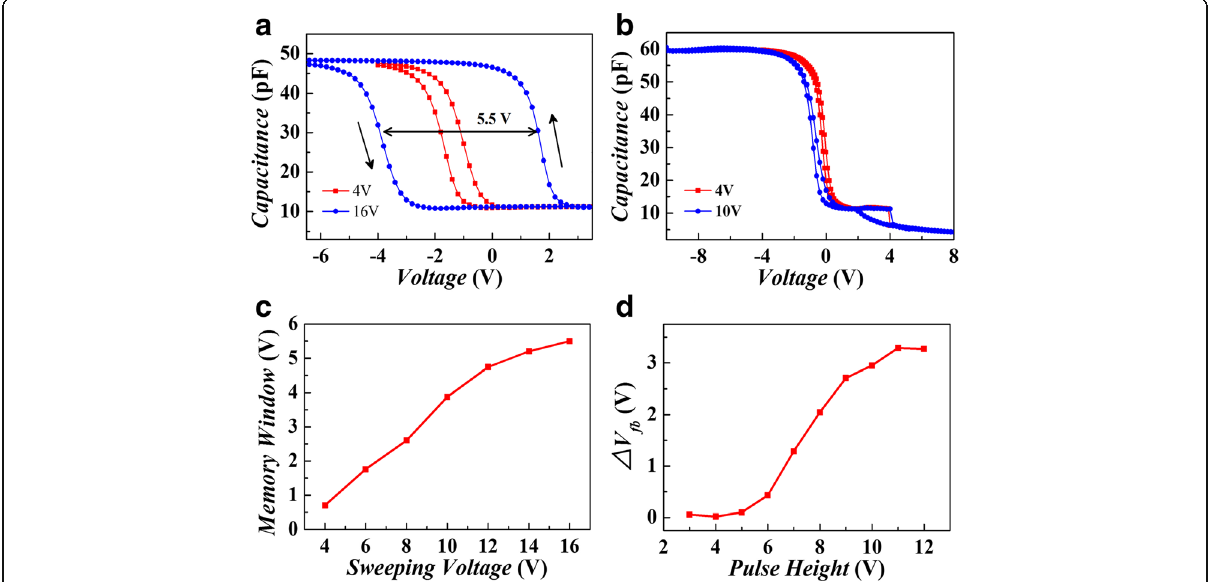
Fig. 2 ( Color online ) Typical high-frequency (1 MHz) CV characteristics of the Au-Al 2 O 3 -TiAlO-SiO 2 -Si device ( a ) and Au-Al 2 O 3 -SiO 2 -Si device ( b ). c Memory window width dependence of the Au-Al